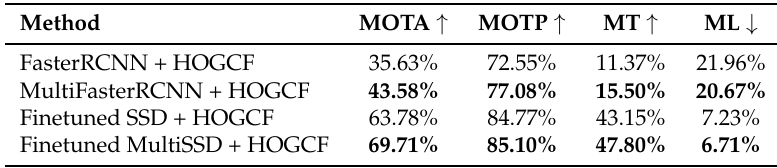
Table 2. Analysis of temporal ROIs augment strategy on validation set.